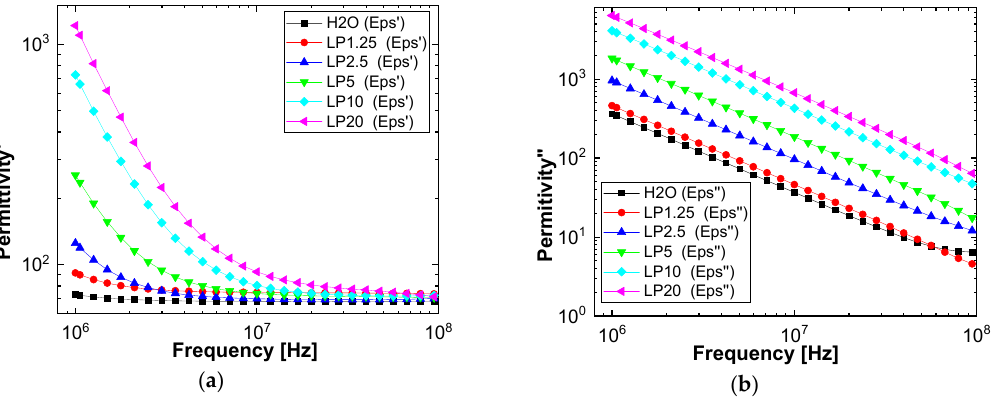
Figure 11. The dependence of the dielectric constant ( a ) and dielectric loss ( b ) with the frequency, in the range of the HF, when the concentration of the LP ( 1 ) solution varies from 0 (black curve) to 0.125 mg/mL (red curve), 0.25 mg/mL (blue curve), 0.5 mg/mL (green curve), 1 mg/mL (cyan curve) and 2 mg/mL (magenta curve).